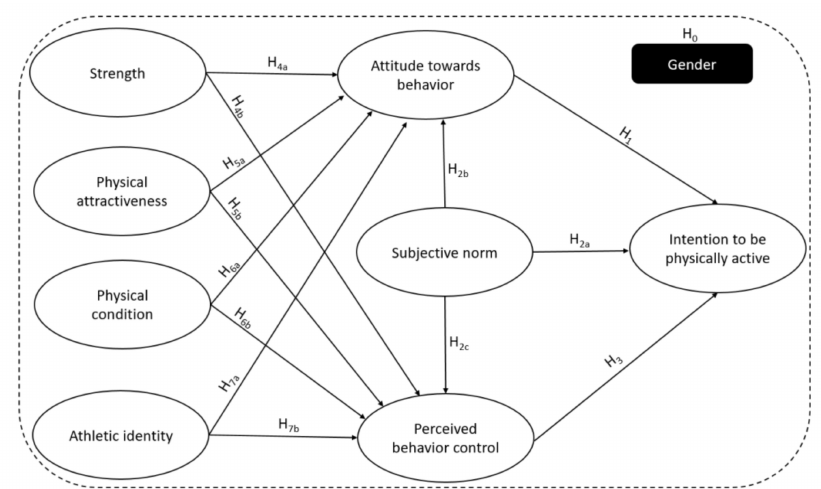
Figure 1. Model of intention to be physically active after finishing secondary school with gender as a